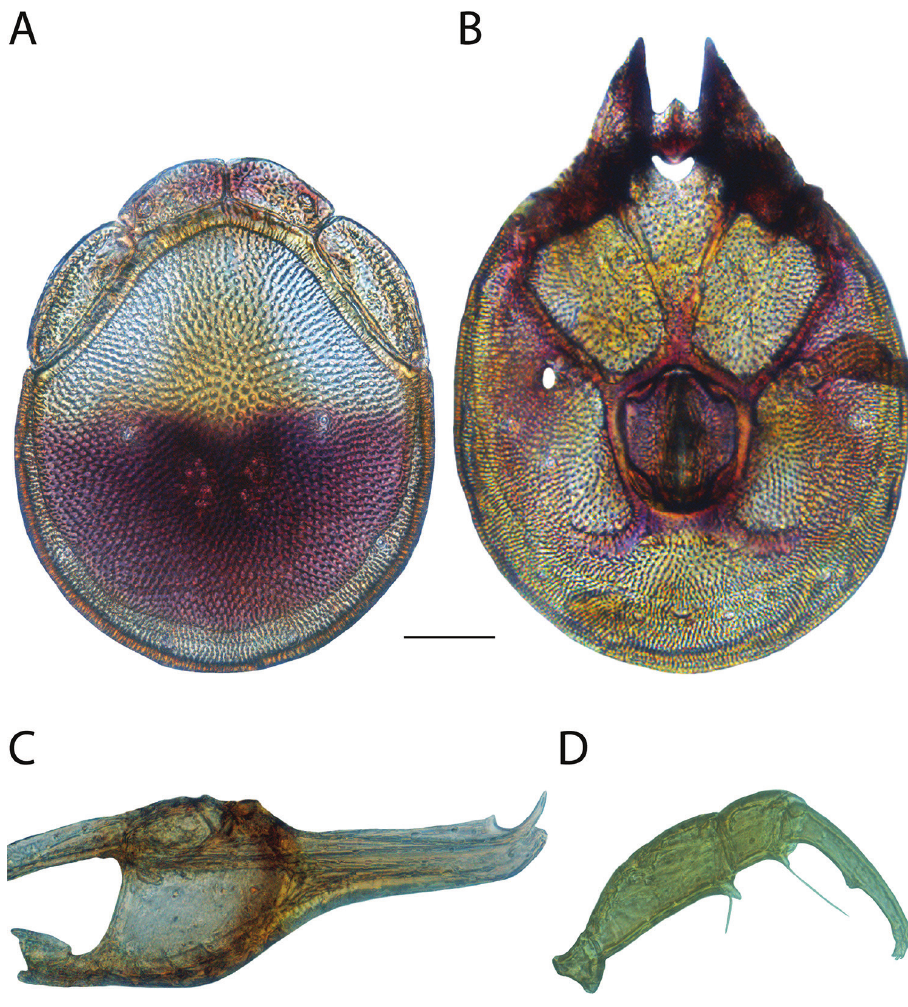
Figure 207. Torrenticola racupalpa sp. n. male: A dorsal plates B venter (legs removed) C subcapitulum D pedipalp (setae not accurately depicted). Scale = 100